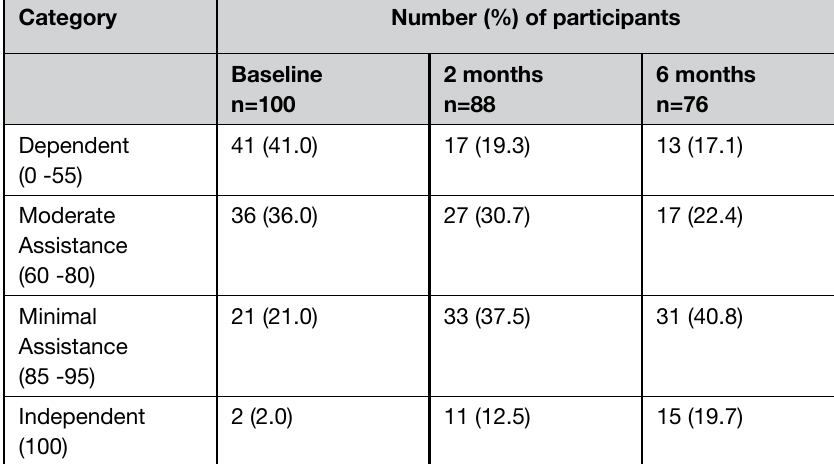
Table 2: Barthel index Score according to participants’ severity for each assessment